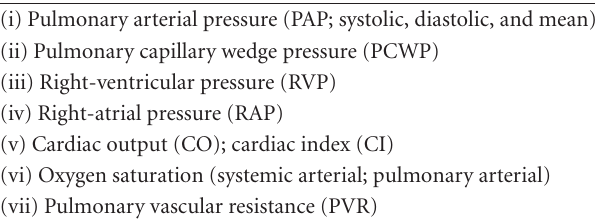
Table 7: Right-heart catheterization: parameters for